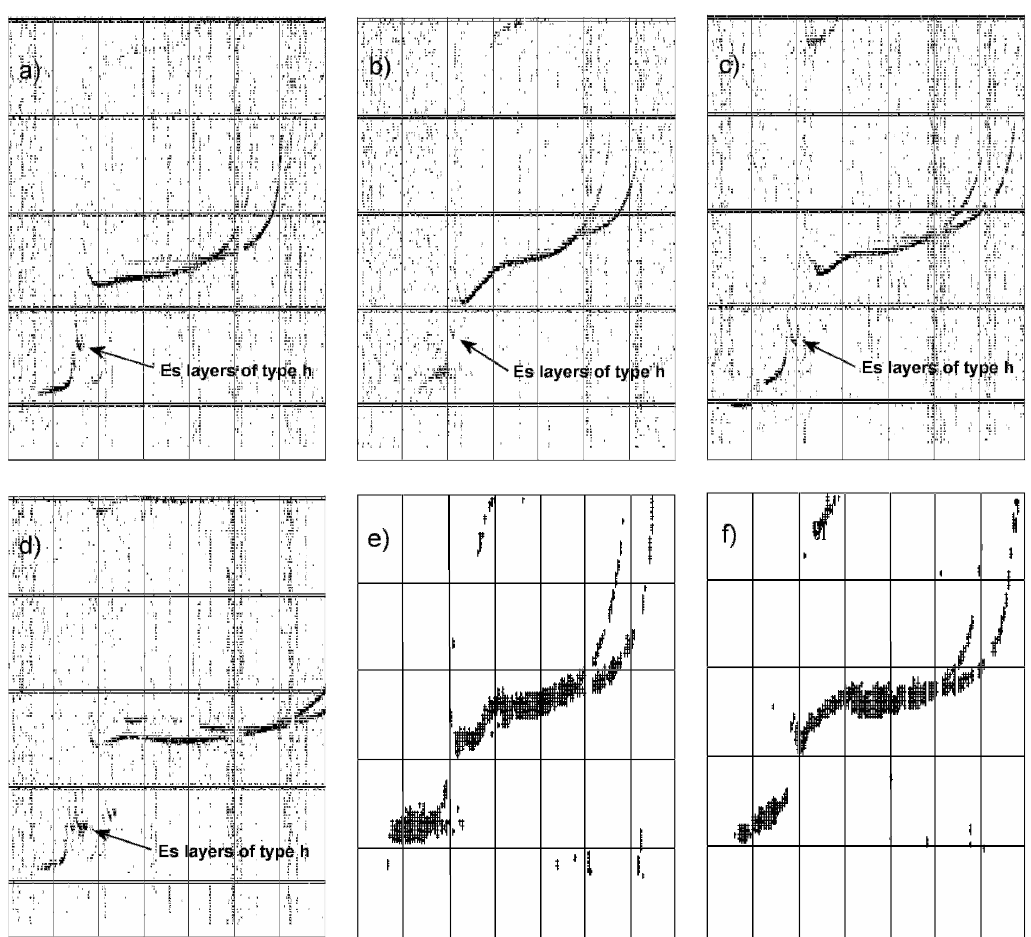
Fig. 6. Ionograms recorded on 14 October 1997 at Rome at (a) 07:00, (b) 13:00, (c) 14:00, and (d) 15:00UT, and at Sofia at (e) 13:00, and (f) 14:00UT. Grid lines are spaced 100km vertically and 1MHz horizontally. At Rome Es layers of type h are visible in all the ionograms, strengthening at 15:00UT; E region trace is almost absent at 13:00UT. Unlike Rome, at Sofia the E region trace is well developed at 13:00UT, and no Es layers of type h are